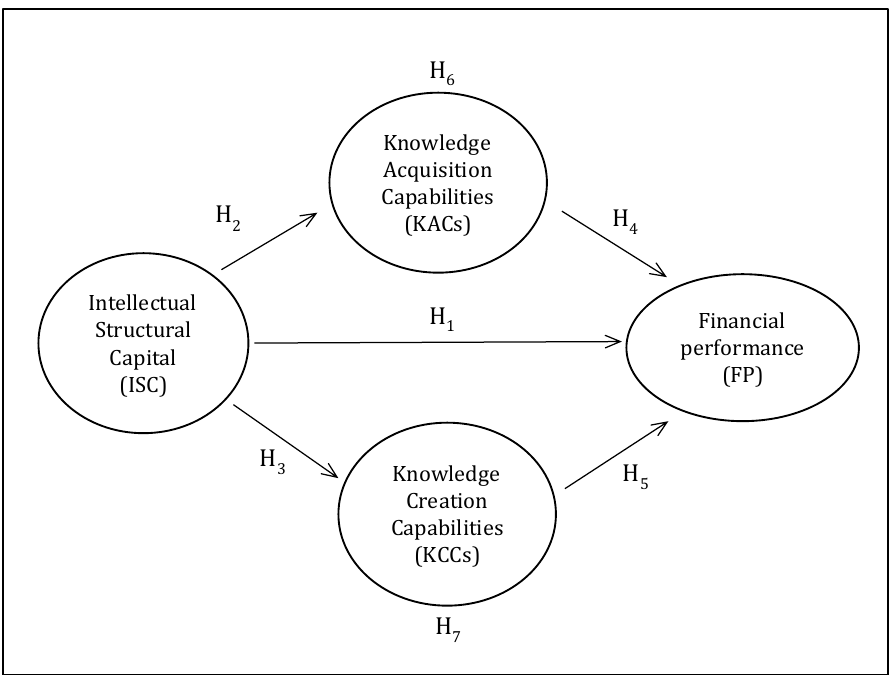
Figure 1: Conceptual